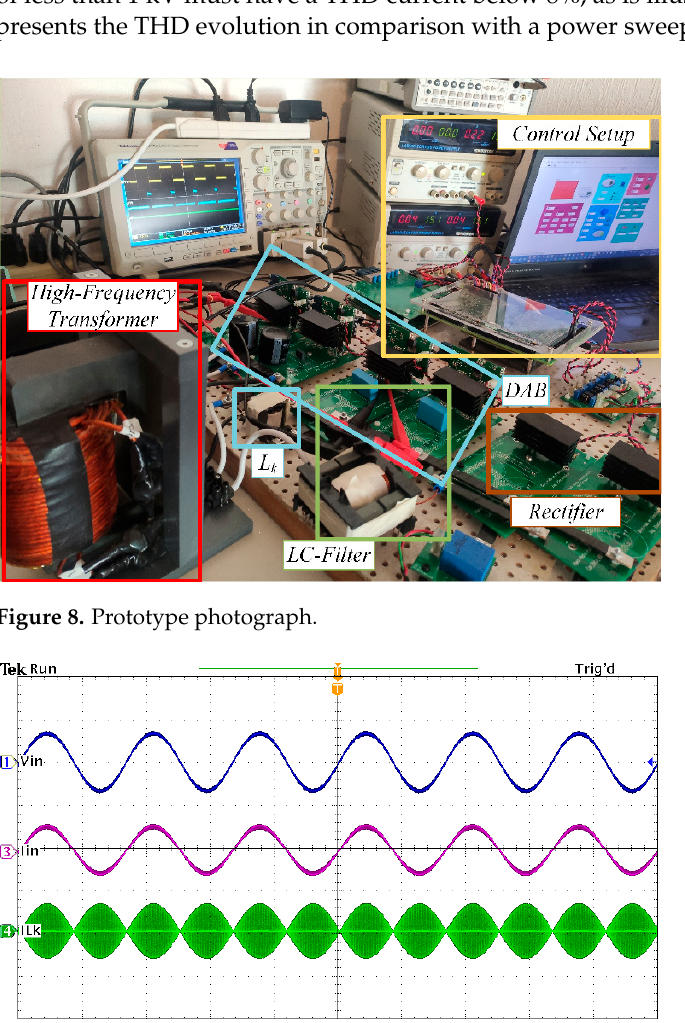
Figure 7. System frequency response in open loop and closed loop.